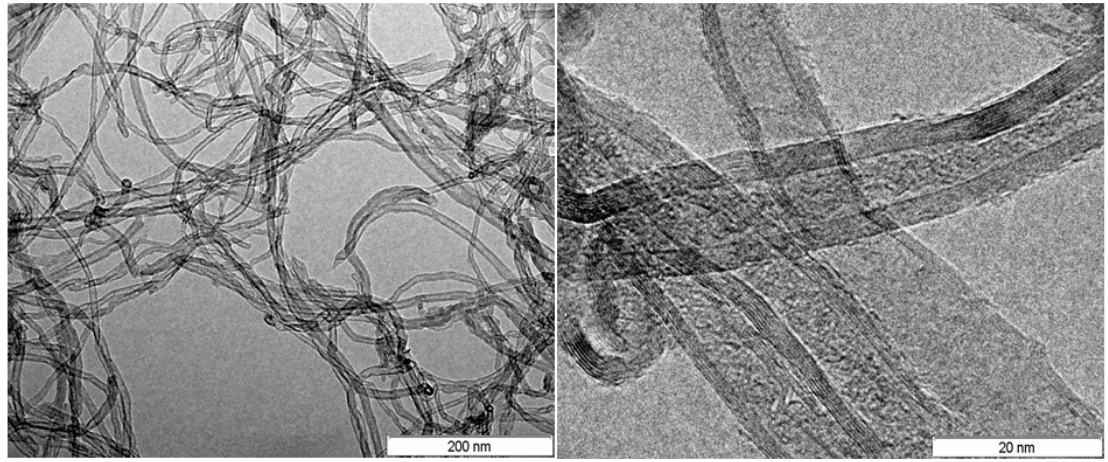
Figure 1. High Resolution Transmission Electron Microscope ( HR-TEM) images of multi-wall carbon nanotubes (MWCNTs) at two different magnifications.